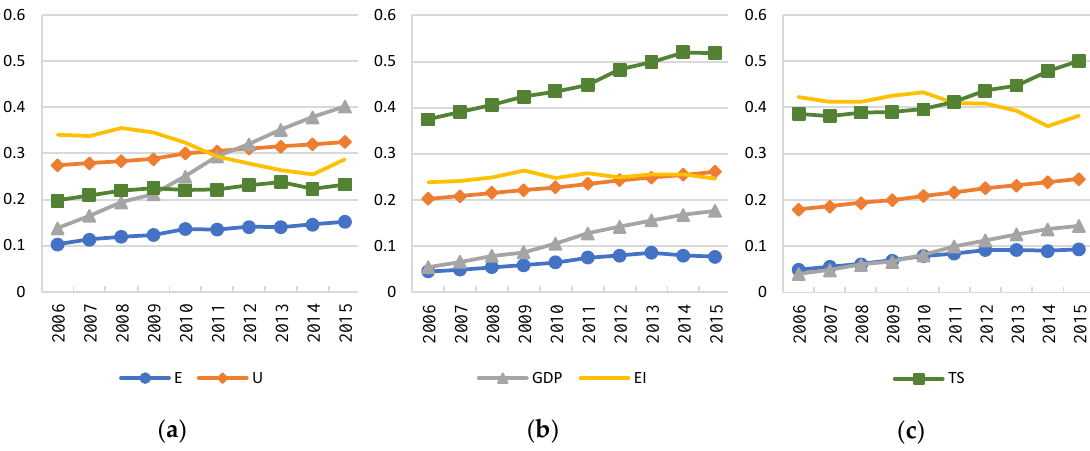
Figure 4. Trends of the variables in three regions (2006–2015). ( a ) Eastern Region; ( b ) Central Region; ( c ) Western Region.